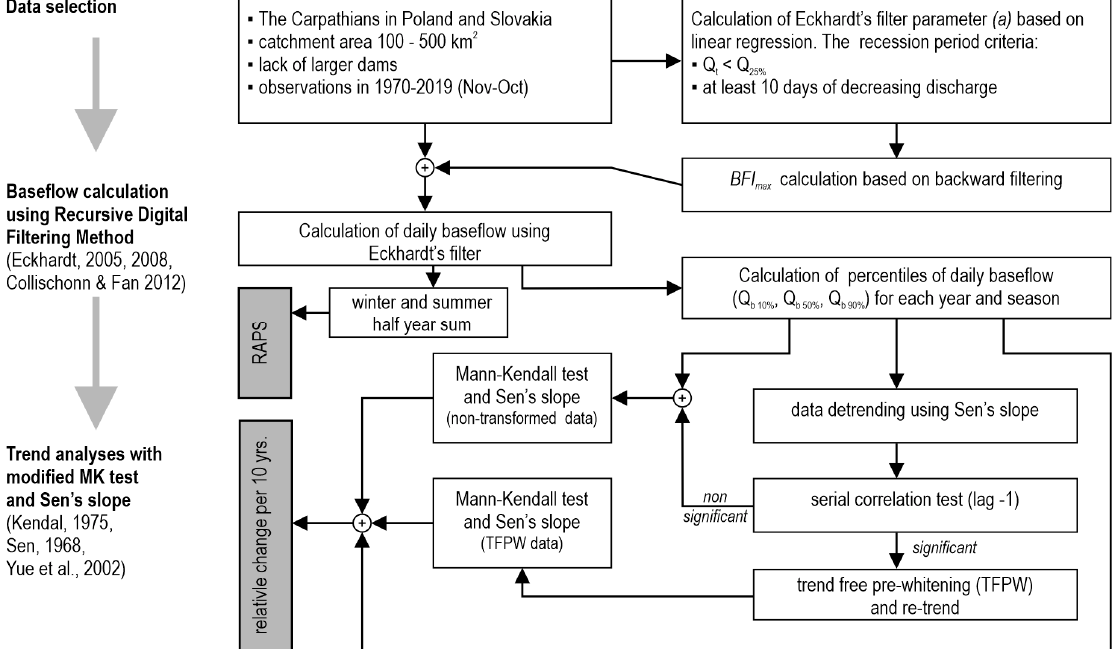
Figure 3. Flowchart of methods used in the study.